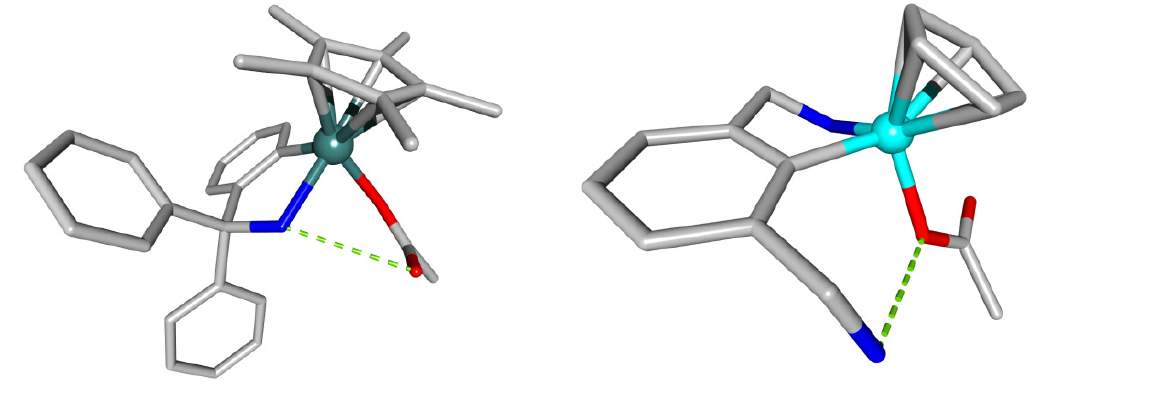
Figure 5. X-ray structures of two different acetate complexes. Left: an iridium (III) complex where the metal binds the carboxyl site, the carbonyl oxygen displaying H-bond with the NH function of the ligand. Right: a cobalt (III) complex where the metal binds the carboxyl site and displays simultaneously H-bond interaction with the NH function of the